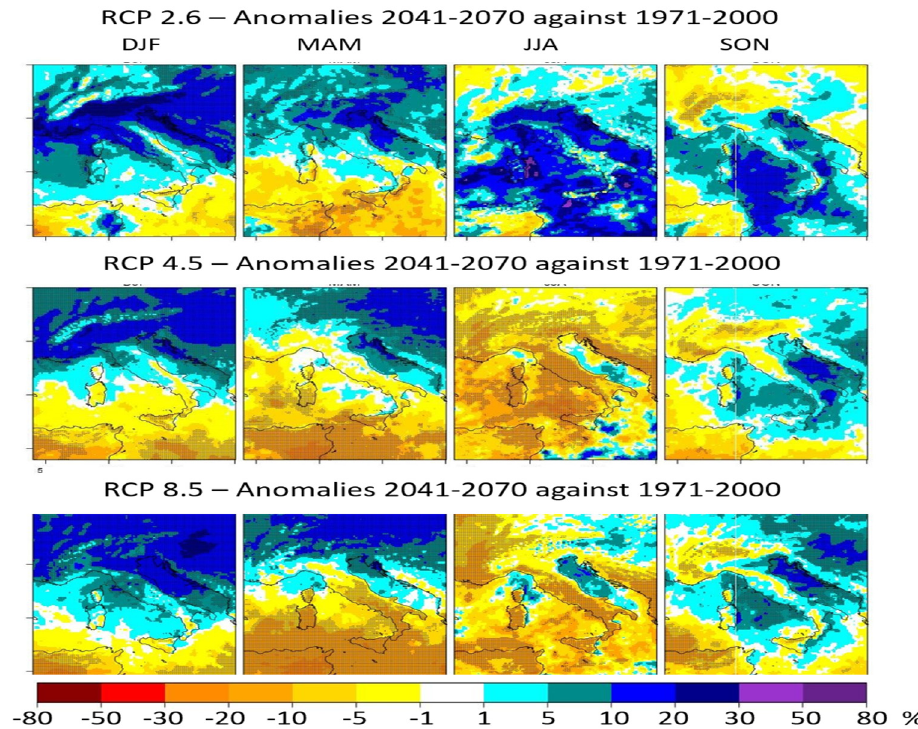
Figure 7. As Figure 6, but for anomalies expected by 2041–2070 against 1971–2000.